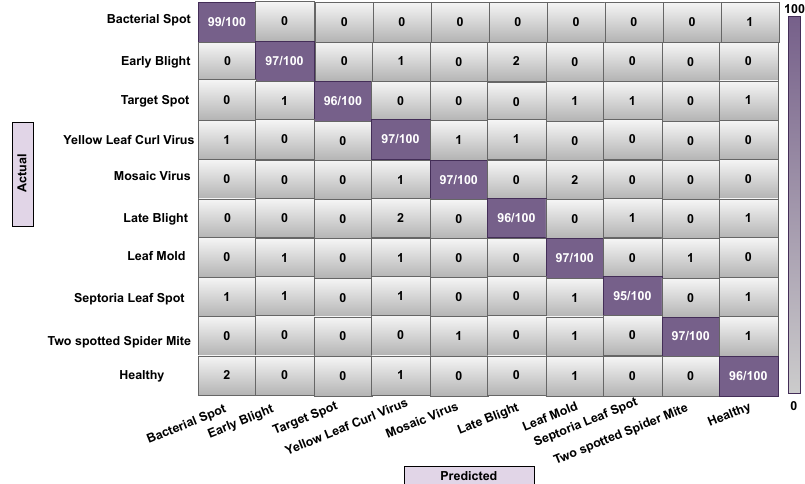
Figure 12. Confusion matrix of ADCLR method during testing.